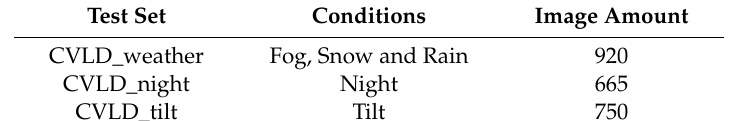
Table 3. Test images sets in various complex environments.